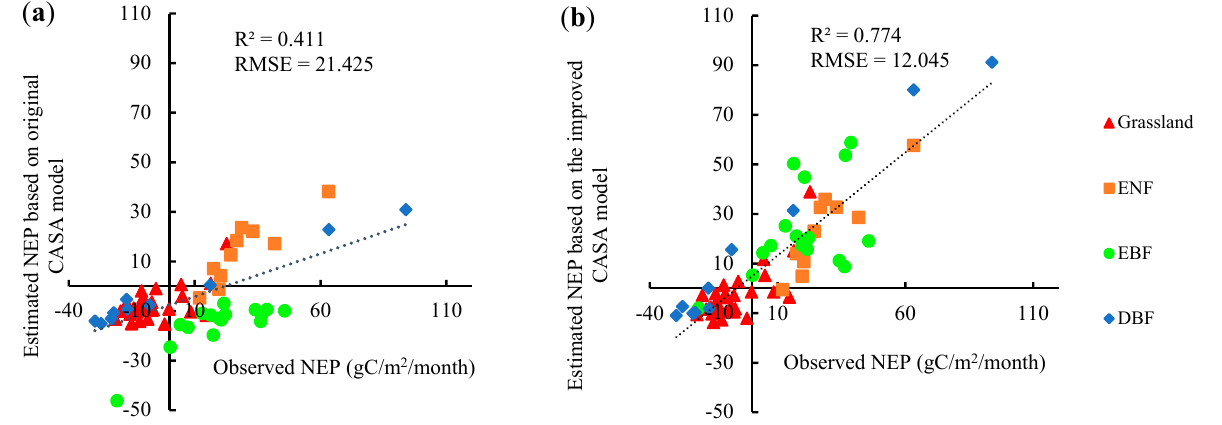
Figure 6. The observed NEP VS the estimated NEP based on the CASA model. ( a ) ε max using vegetation classification; ( b ) ε max of fixed value 0.389 ( gC · MJ − 1 ) .